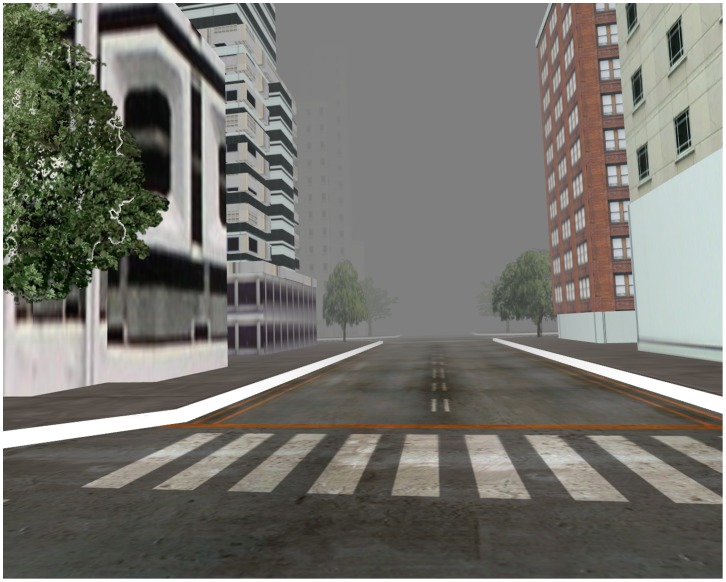
Foggy virtual city.